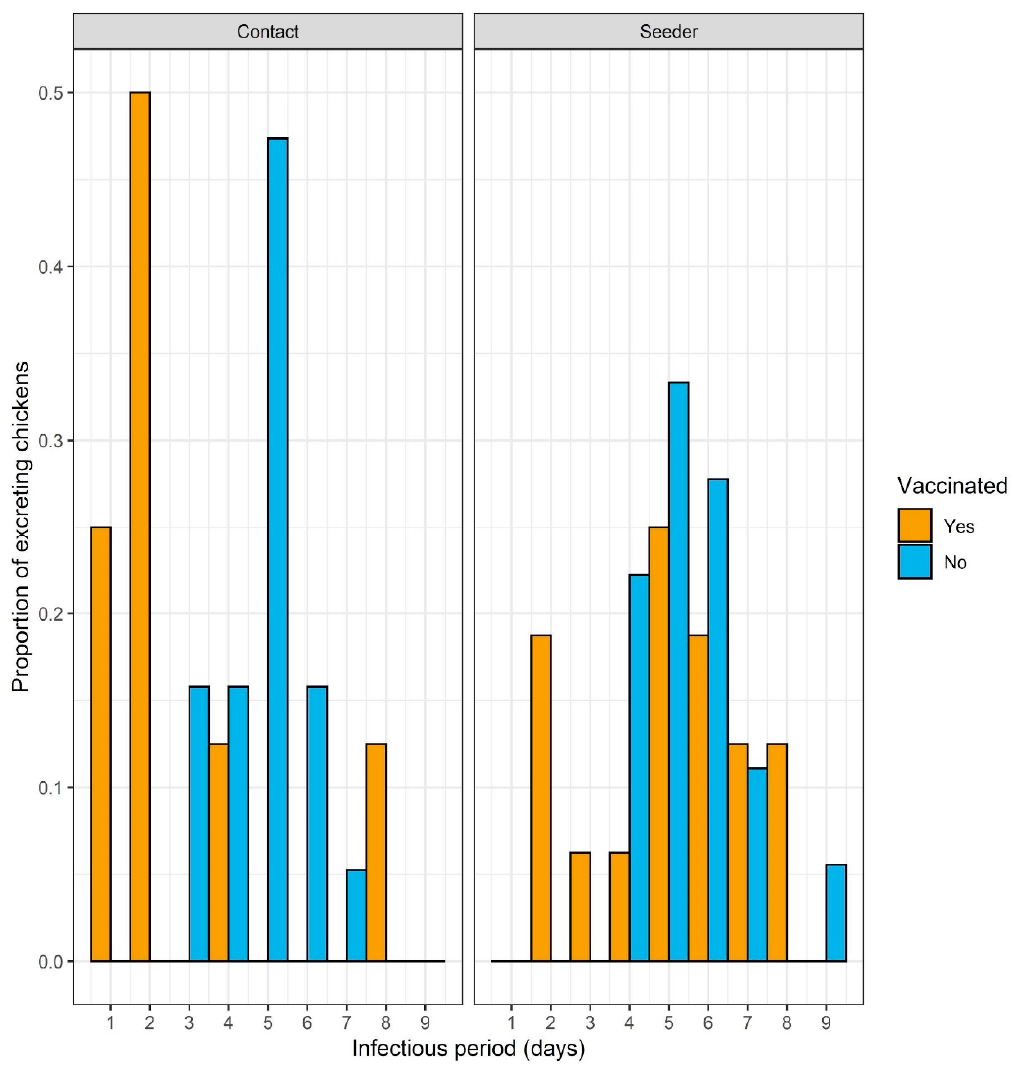
Figure 4. Distribution of infectious periods of the contact (left panel) and seeder (right panel) birds. In the vaccinated contact groups the infectious period of two birds were censored from the analysis at day 14 dpi. Both were infectious for one day.